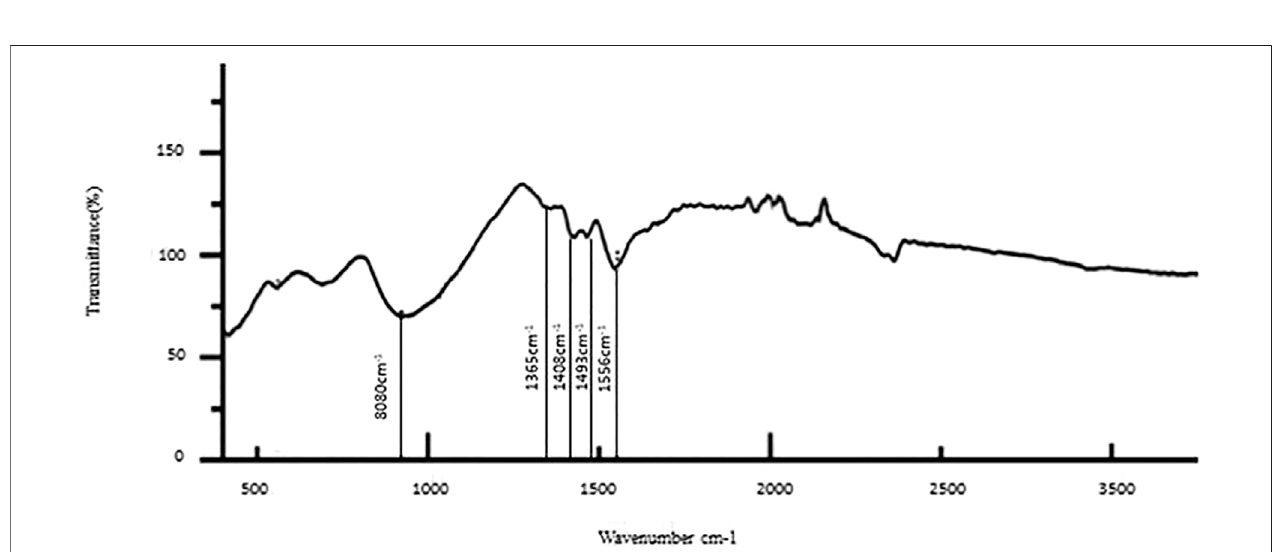
FIGURE 6 | Bioactive evaluation of glass ionomer cement (GIC) and silver nanoparticles (AgNPs) 0.6% sample with dentin.